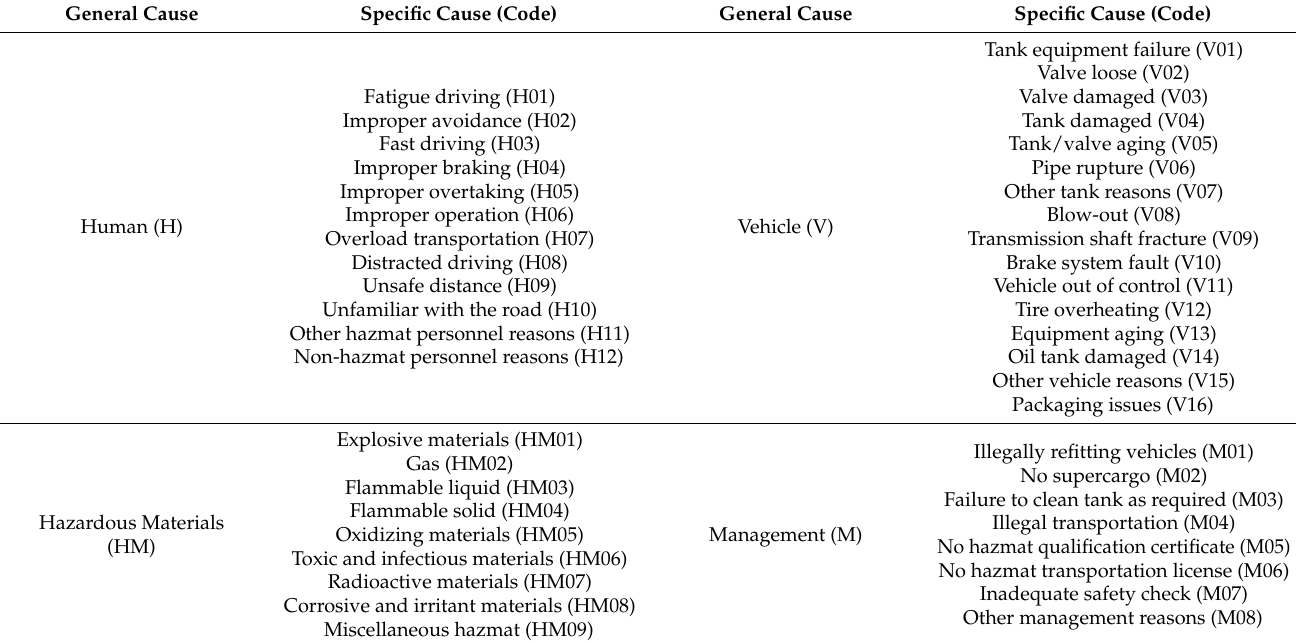
Table 1. Specific causes of